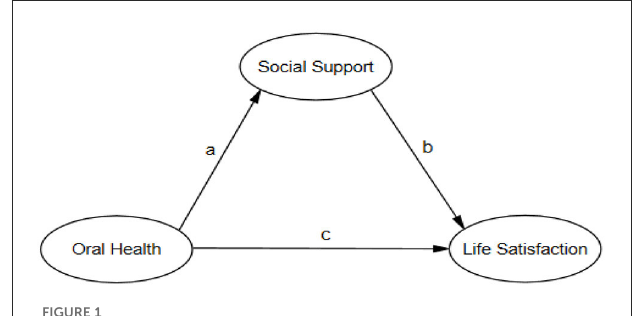
FIGURE1 The conceptual framework of mediation model. a refers to the direct path from oral health to social support; b refers to the direct path from social support to life satisfaction; c refers to the direct path from oral health to life